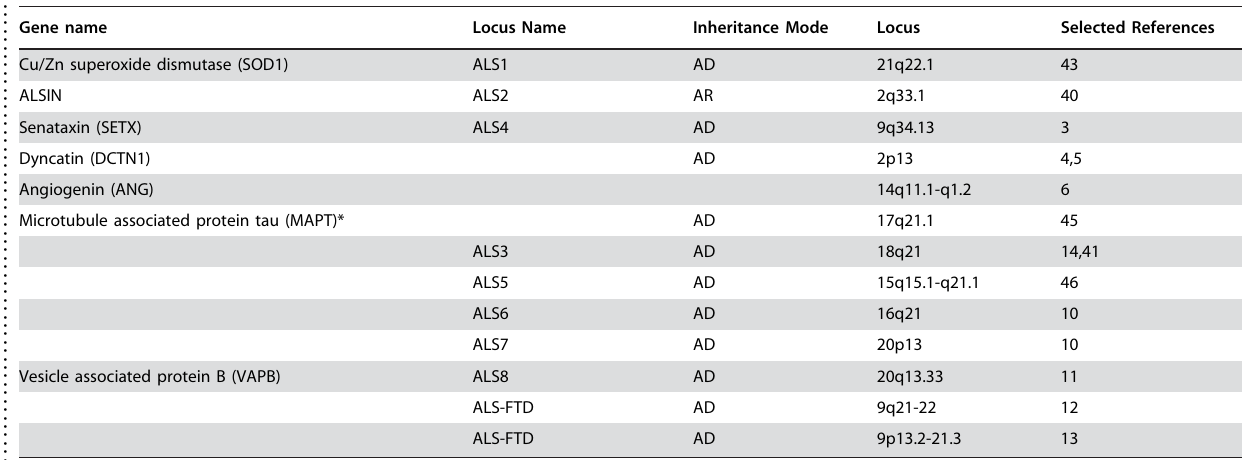
Table 1. Loci Linked to Mendelian Causes of ALS. .. ... .... ... ... .... ... ... .... ... ... .... ... ... .... ... ... .... ... ... .... ... ... .... ... ... .... ... ... .... ... ... .... ... ... .... ... ... .... ... ... .... ... ...